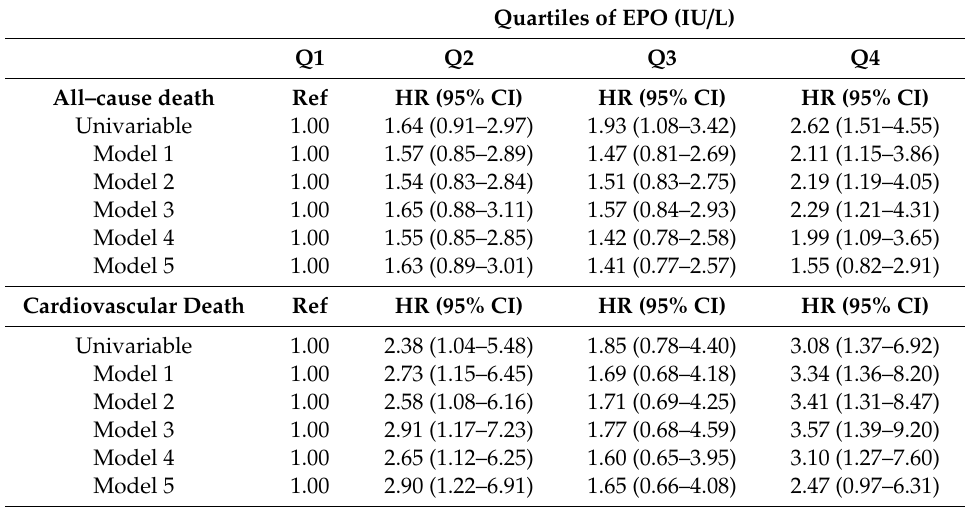
Table 3. Association between erythropoietin quartiles and risk of all-cause and cardiovascular death.